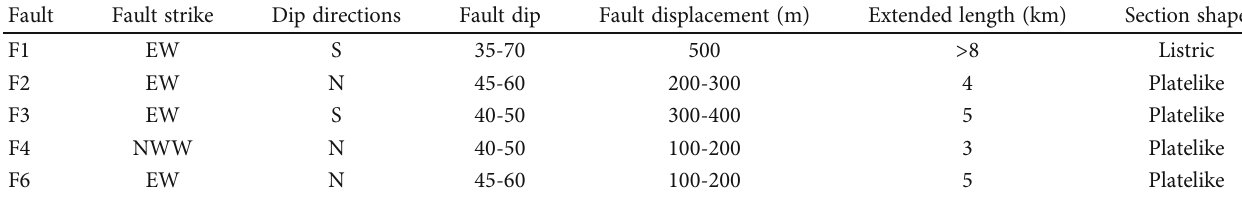
Table 2: Major fault elements of the middle part.